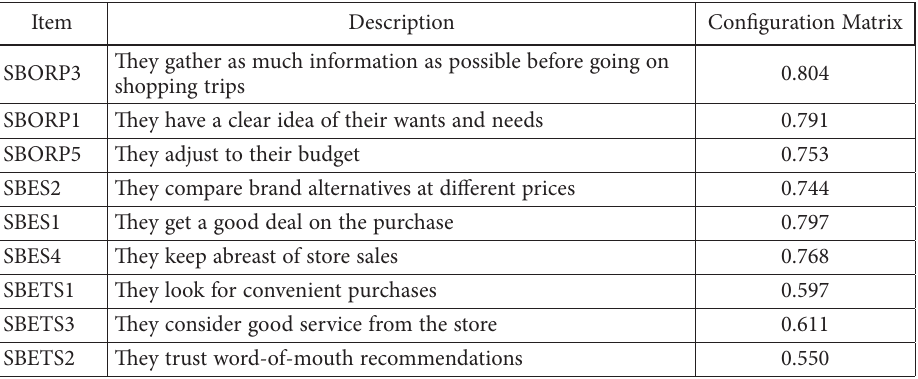
Table 3. Principal component analyses for smart behavior